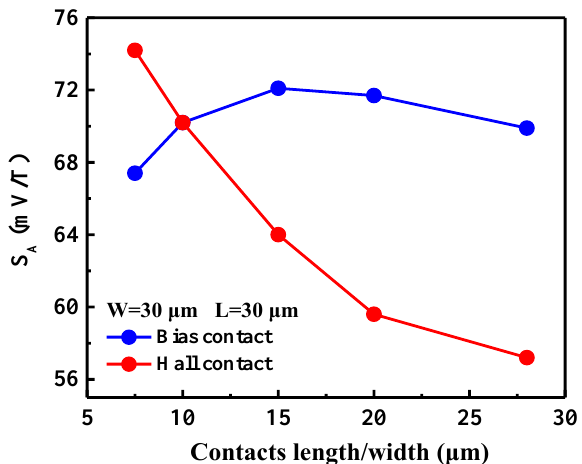
Figure 7. Simulations on a 30 µm × 30 µm square sensor with different lengths L a of Hall contacts and widths W b of bias contacts.